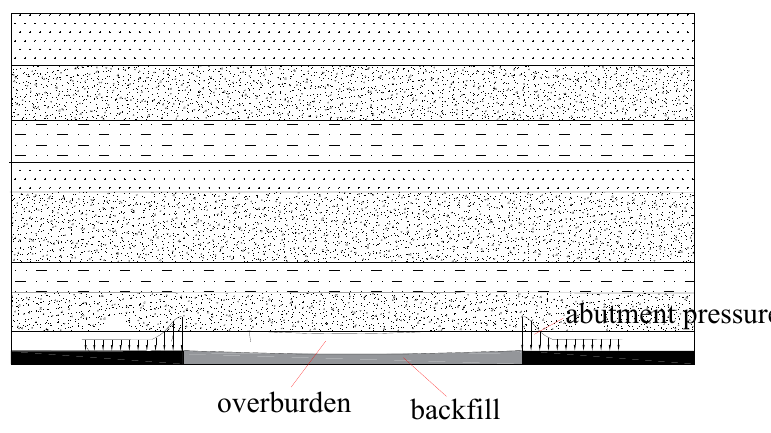
Figure 17. A structural model of strata movement in backfill mining.